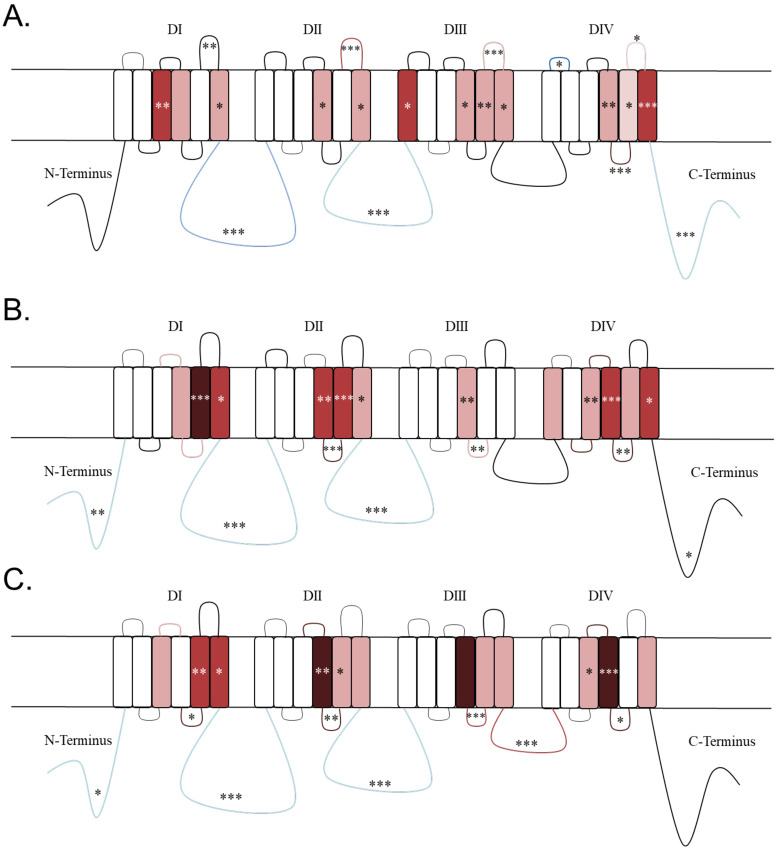
Heat map for A) NaV1.1, B) NaV1.2, and C) NaV1.6.Significant p-values on the heat maps were indicated as follows: ***0.001, ** = 0.001–0.01, * = 0.01–0.05. Regions are color-coordinated in increasing darkness to indicate increased logarithmic odd ratio values. Red indicates pathogenic regions, while benign regions are displayed in blue.